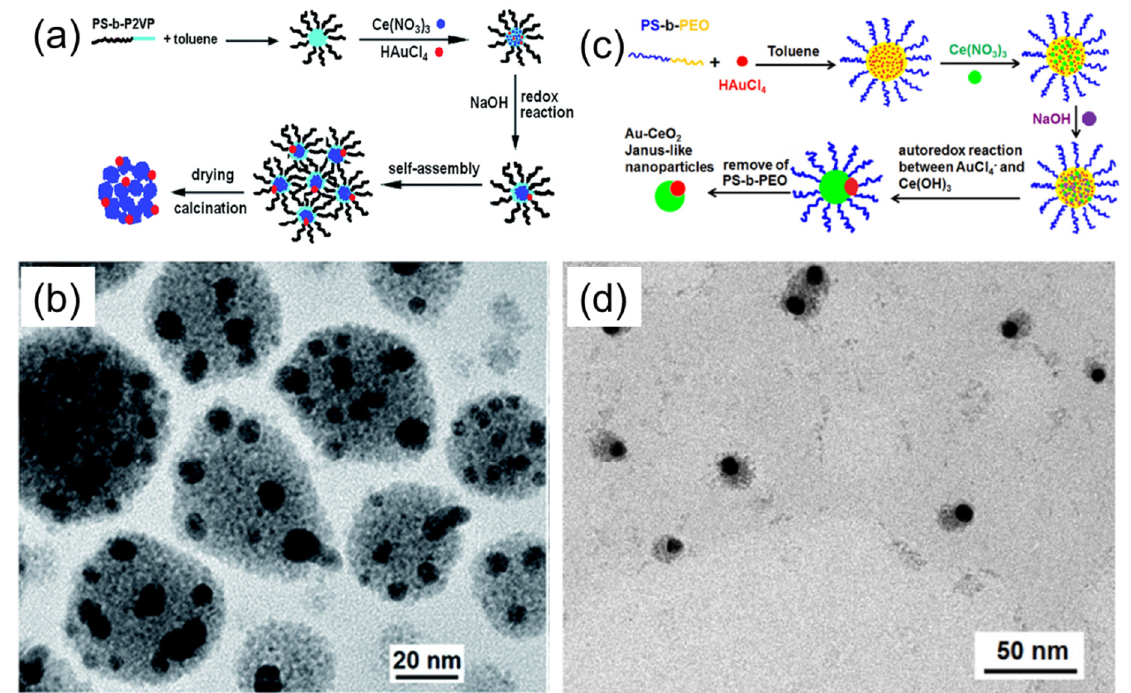
Figure 6. ( a ) Schematic illustration of the process leading to the formation of catalytically active, Au–CeO 2 strawberry-like particles, using PS– b –P2VP/Ce(NO 3 ) 3 /HAuCl 4 composite micelles. ( b ) TEM image of Au–CeO 2 Janus particles, prepared using PS– b –PEO/Ce(NO 3 ) 3 /HAuCl 4 composite micelles underoptimized conditions. Adapted from [26]. ( c ) Schematic il- lustration of the process leading to the formation of Au–CeO 2 Janus-like nanoparticles using PS– b –PEO/Ce(NO 3 ) 3 /HAuCl 4 composite micelles. ( d ) TEM image of Au–CeO 2 Janus particles prepared using PS– b –PEO/Ce(NO 3 ) 3 /HAuCl 4 composite micelles under optimized conditions. Adapted from [27].